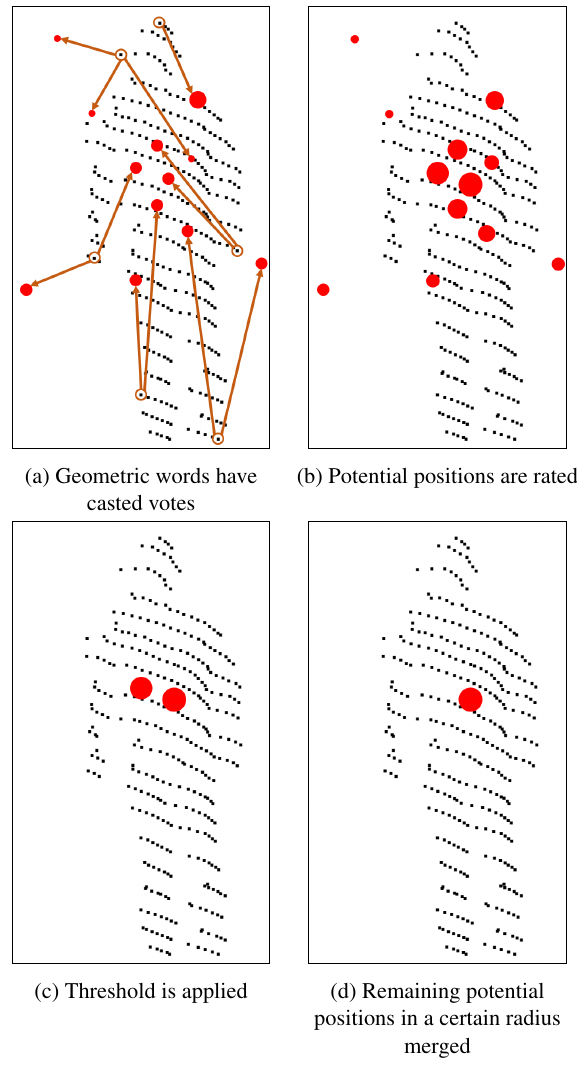
Figure 3. Illustration of the main processing step of our person